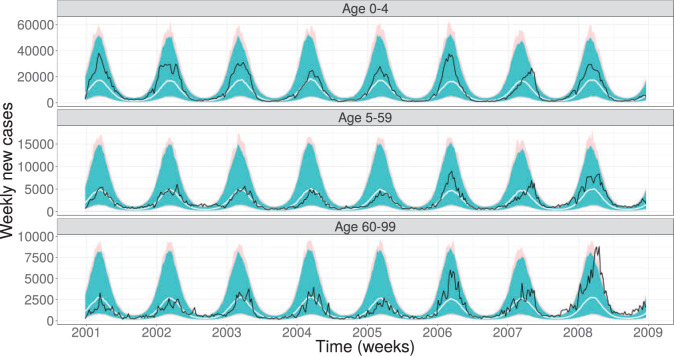
The 95% prediction interval (light shading) for 1000 realizations of Model St\documentclass[12pt]{minimal}
\usepackage{amsmath}
\usepackage{wasysym}
\usepackage{amsfonts}
\usepackage{amssymb}
\usepackage{amsbsy}
\usepackage{upgreek}
\usepackage{mathrsfs}
\setlength{\oddsidemargin}{-69pt}
\begin{document}
}{}$+$\end{document}St\documentclass[12pt]{minimal}
\usepackage{amsmath}
\usepackage{wasysym}
\usepackage{amsfonts}
\usepackage{amssymb}
\usepackage{amsbsy}
\usepackage{upgreek}
\usepackage{mathrsfs}
\setlength{\oddsidemargin}{-69pt}
\begin{document}
}{}$+$\end{document} evaluated at the maximum likelihood estimate for the rotavirus incidence data (solid back line) and the median (solid white line). Furthermore, the 95 % prediction interval of these 1000 realizations for only the transmission model is shown (darker shading).